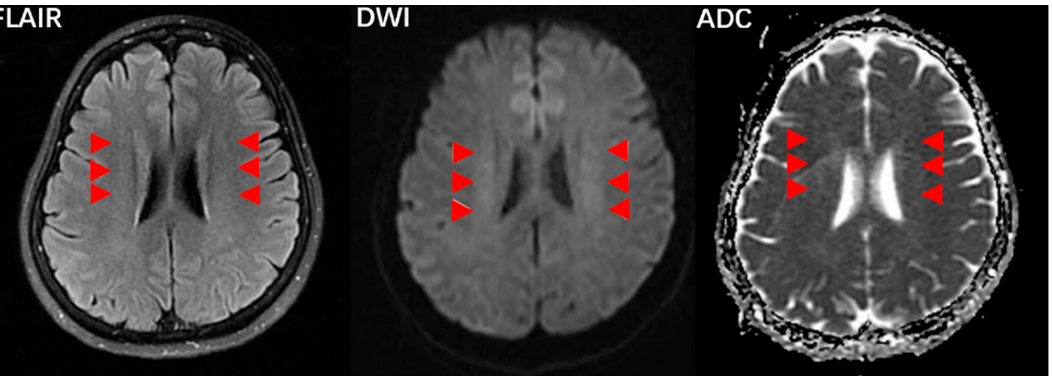
Figure 2. MRI findings in patients with cerebral venous outflow stenosis and IJVS conduces bilateral and symmetrical cloudy-like white matter hyperintensity (Red arrow) surrounding ventricles and centrum semiovale: T2W-FLAIR, DWI, and ADC.